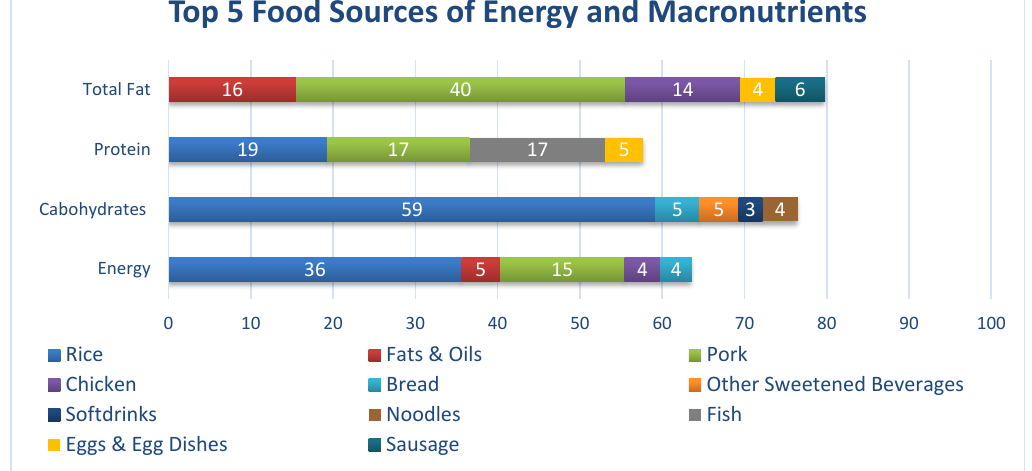
Figure 3. Percentage contributions of each food groups to the total energy, carbohydrate, protein, and total fat intake.